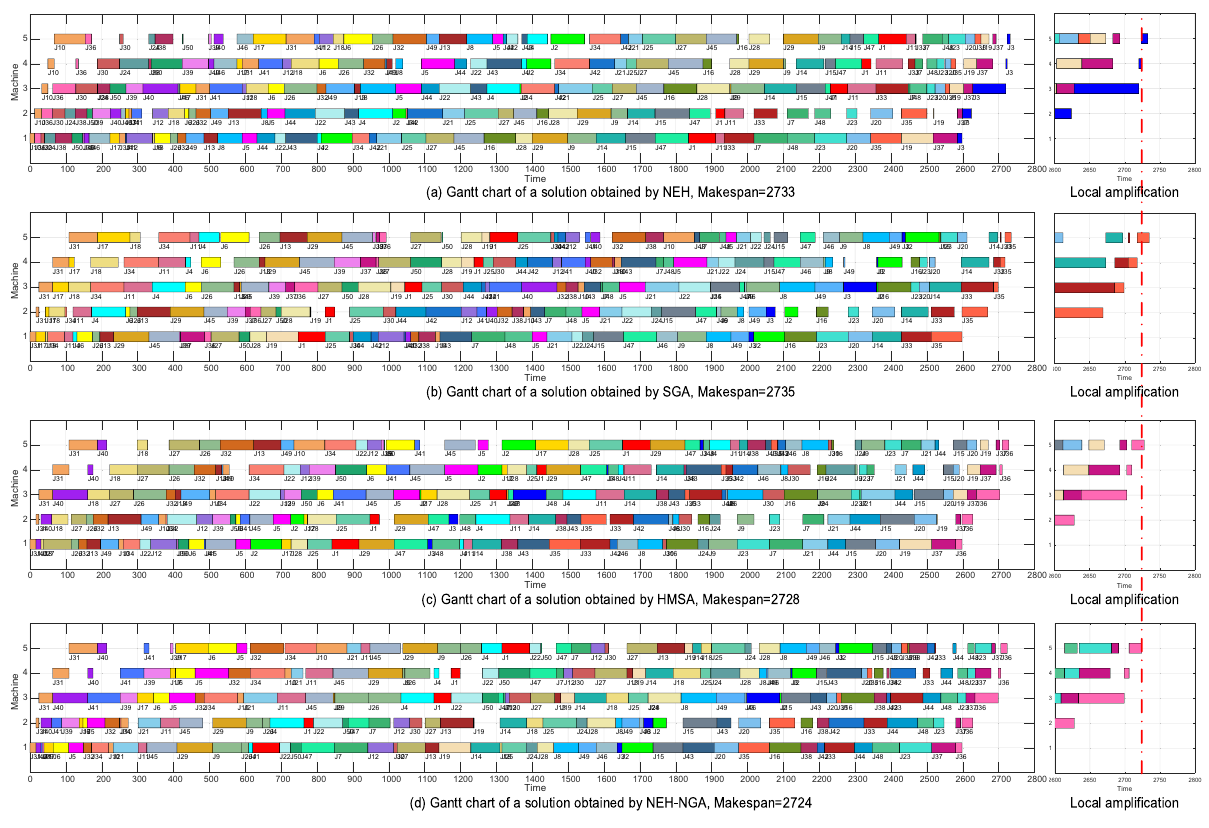
Figure 11. Gantt charts of different solutions to “Ta31” obtained by NEH, SGA, HMSA and NEH-SGA.